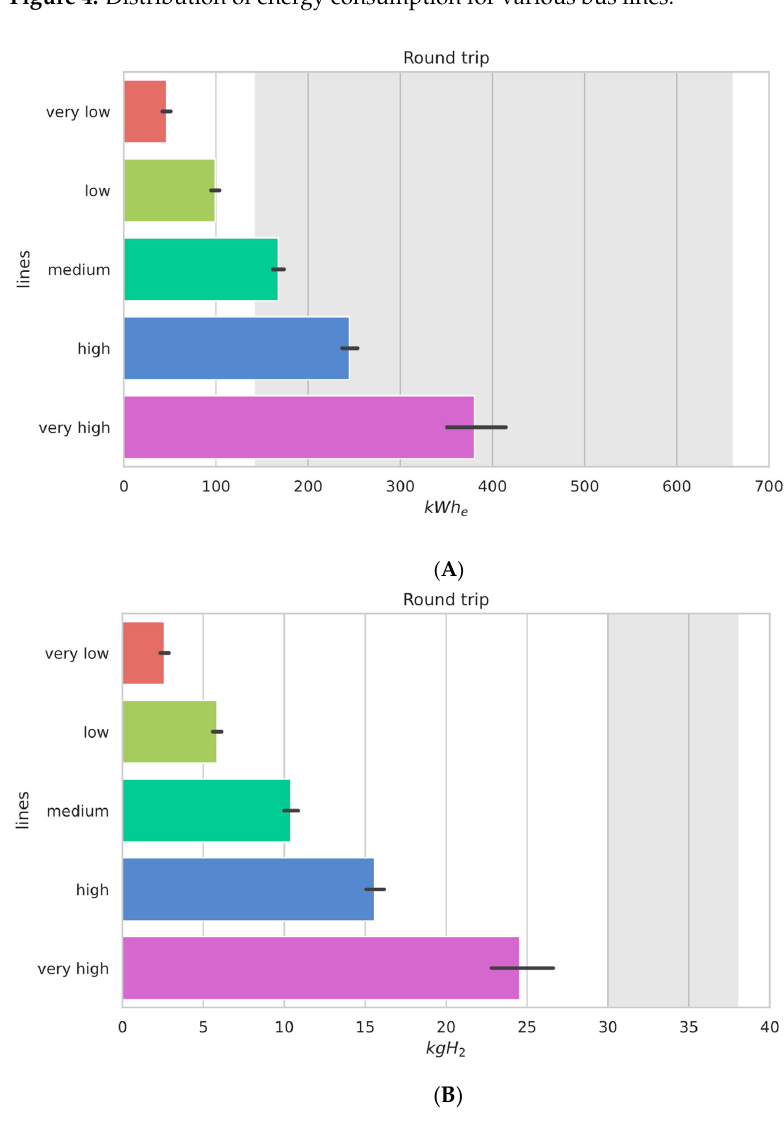
Figure 5. Energy required for each cluster of round-trip bus lines, the background dark grey color shows the battery capacity available on the market for BEBs ( A ) and the tank capacity available for the FCEBs ( B ). The number of lines for each cluster are not equally distributed. In fact, 9 lines are in the purple cluster, 17 in the blue cluster, 31 in the green cluster, and, respectively, 65 and 102 in the light green and the red cluster.